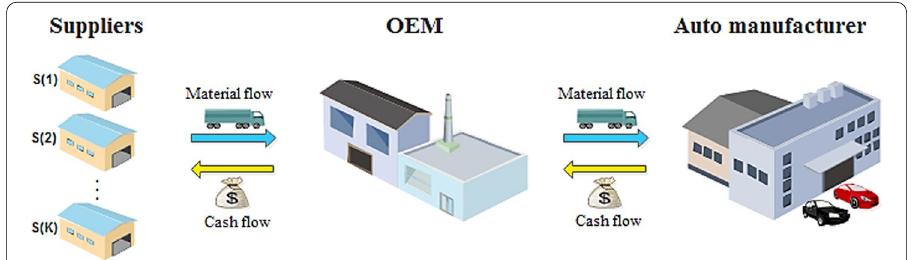
Fig. 1 The structure of the supply chain considered in this